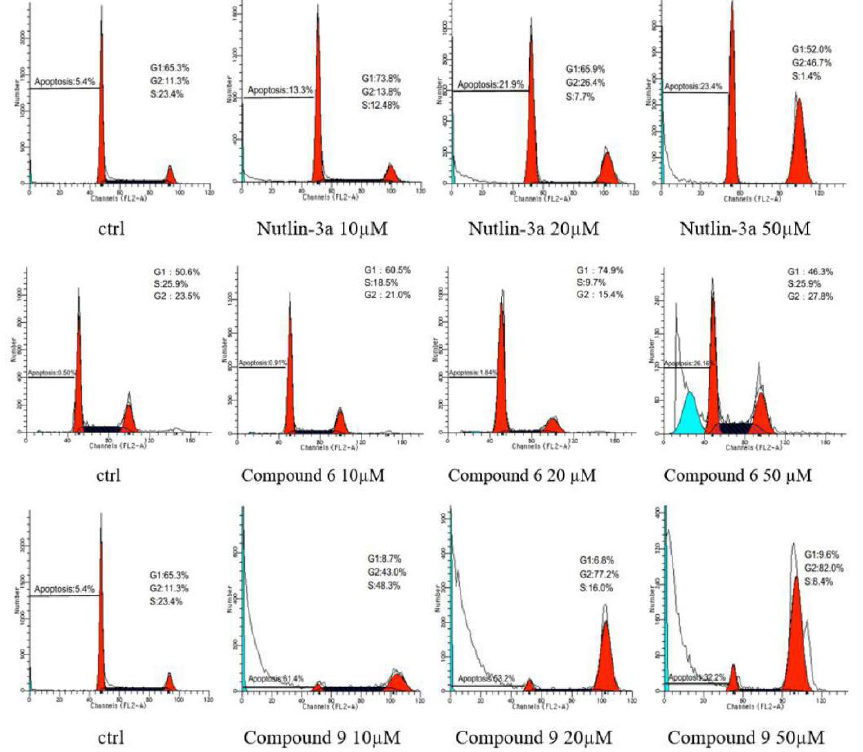
Figure 1. G2 / M phase arrest and the induction of apoptosis in HCT116 cells after treatment with compounds 6 , 9 , and Nutlin-3a .